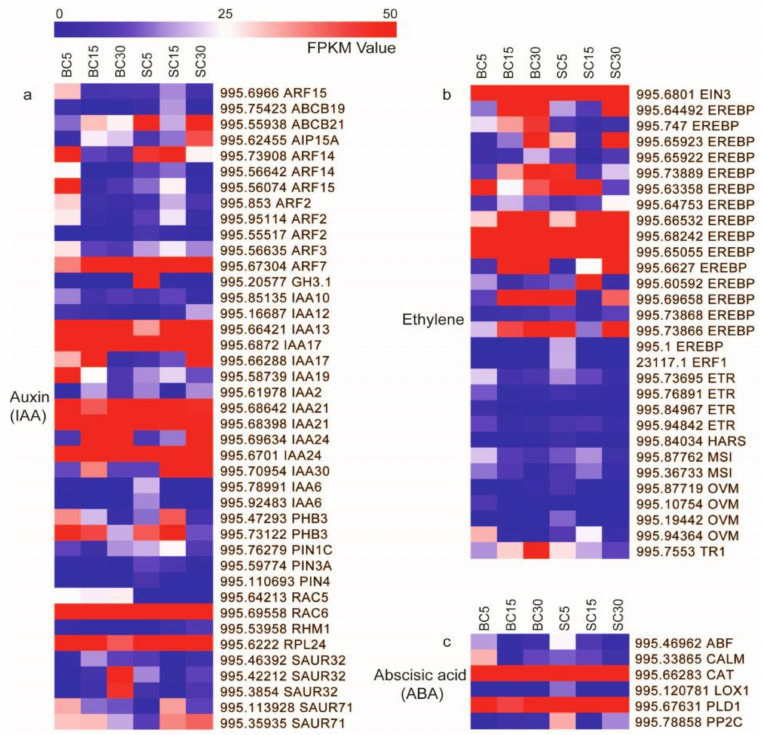
Figure 4. Heatmap of differentially expressed genes assigned to hormone signal transduction pathways in the six D. sinicus transcriptomes: BC5, BC15, BC30, SC5, SC15, and SC30. DEGs related to ( a ) auxin, ( b ) ethylene, and ( c ) abscisic acid. FPKM (fragments per kilobase of exon per million mapped reads) values range from 0 to